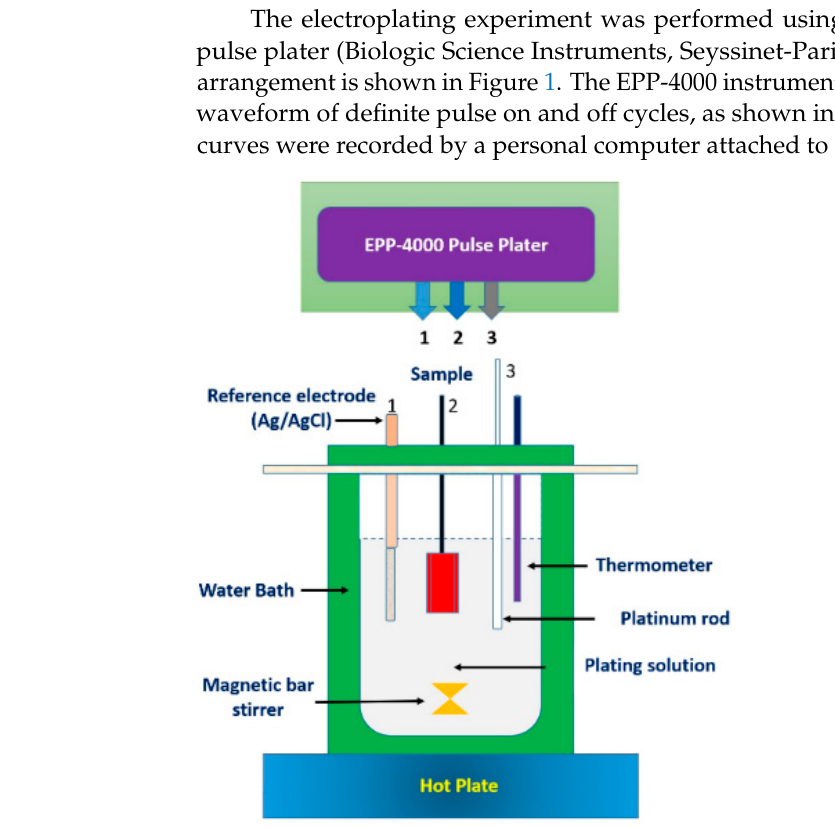
Table 1. Chemical bath compositions and operating parameters.